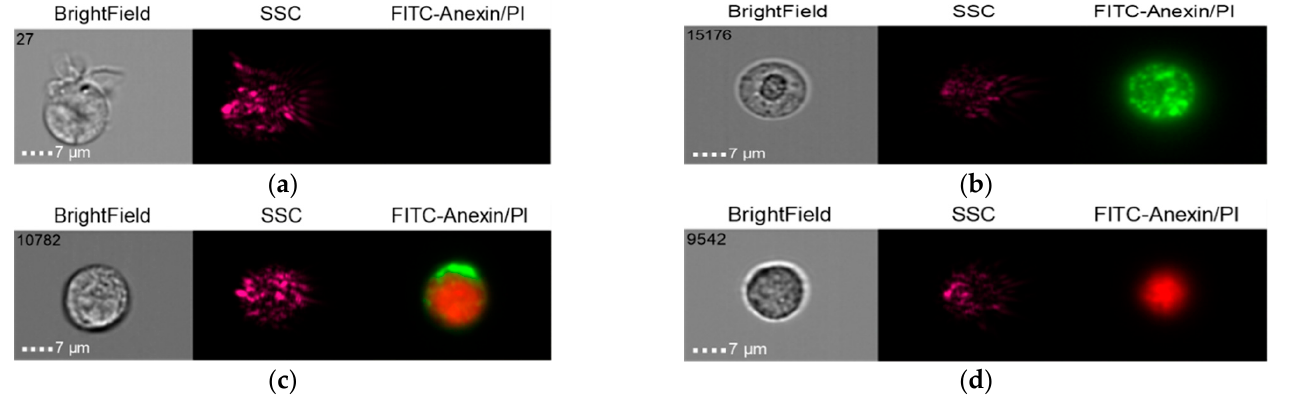
Figure 12. Live cells ( a ), early apoptosis ( b ), late apoptosis ( c ), necrosis ( d ) after co-culture of Alpha